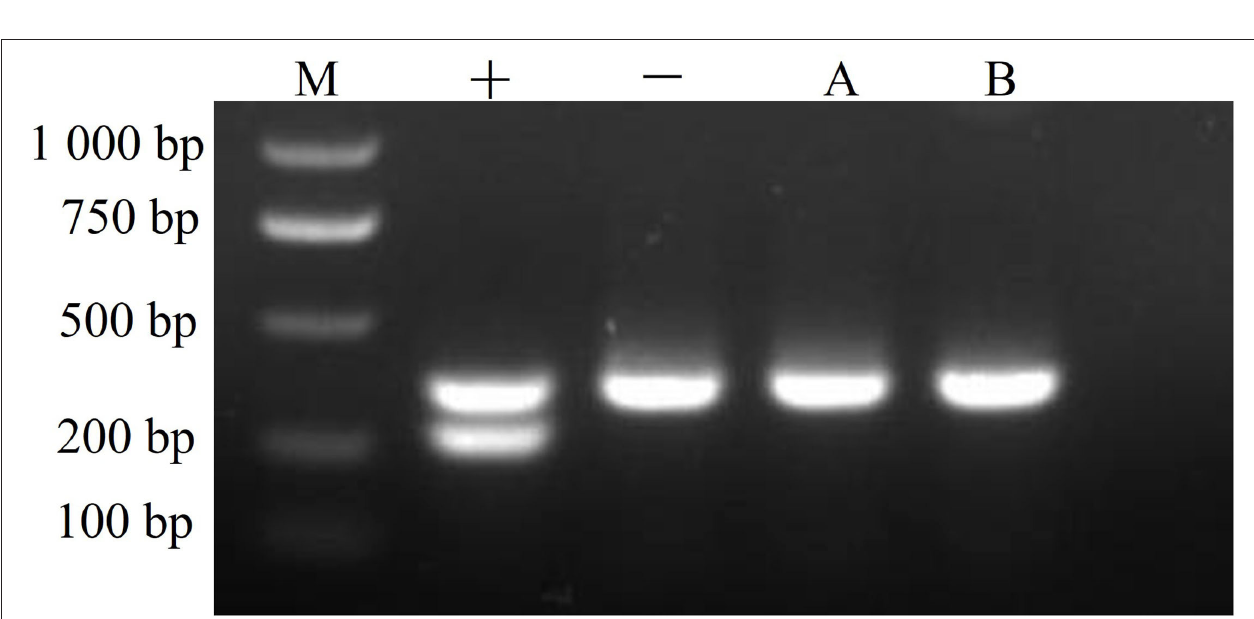
FIGURE 11 | Mycoplasma detection. The CMT-1026 cell line exhibited no mycoplasma contamination. M, maker; + , positive control; –, negative control; A, culture media; B, CMT-1026 cells. revealed that CMT-1026 lacked expression of ER, PR, and HER- 2 and therefore was another triple negative cell line, which may be a candidate for investigation of immunotherapy targets.